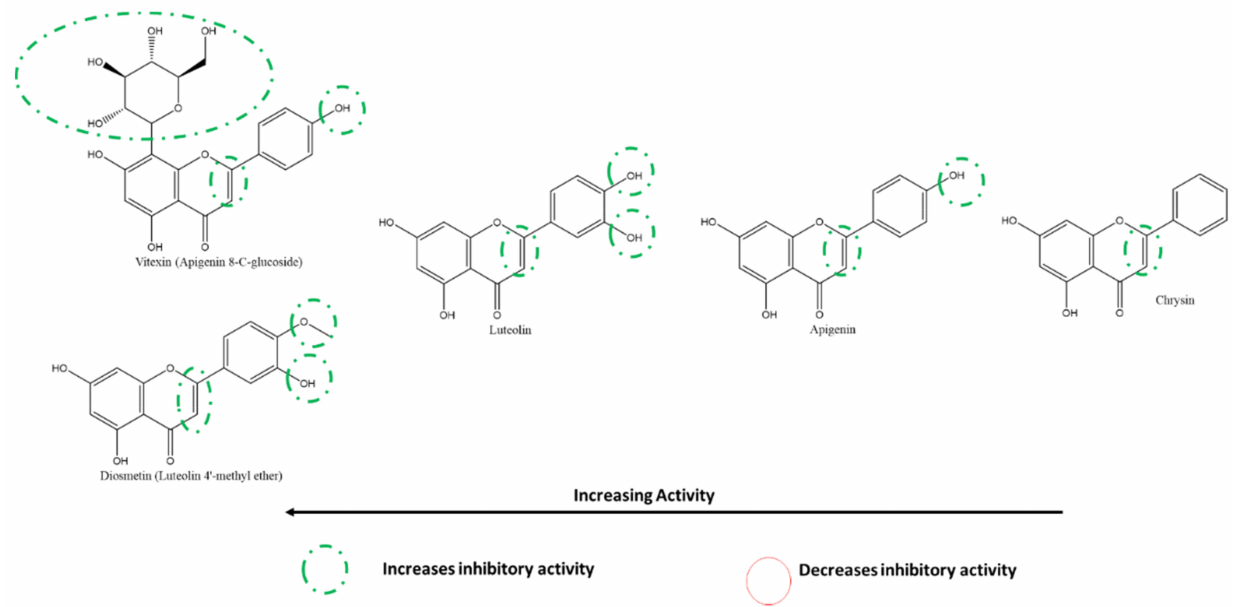
Figure 12. Structure–activity relationships of various flavones against SARS-CoV-2 3CLpro, adapted from the experiments of [118] using cell-free based in vitro FRET assays. Substitutions and groups that result in an increase/decrease in inhibitory activities are shown in red and green,